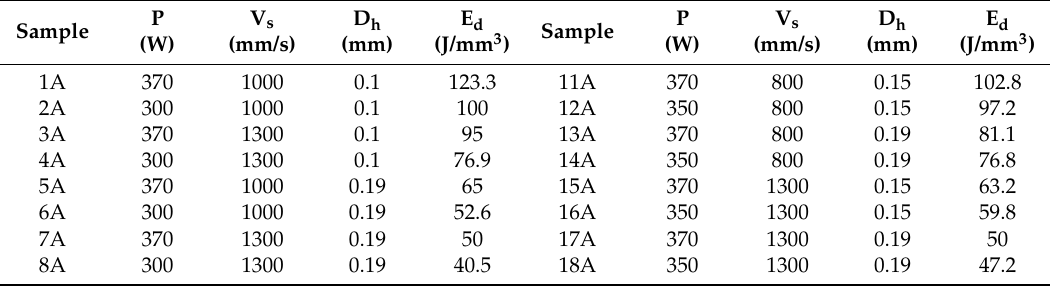
Table 2. The SLM process parameters used for building the Al6061_200C